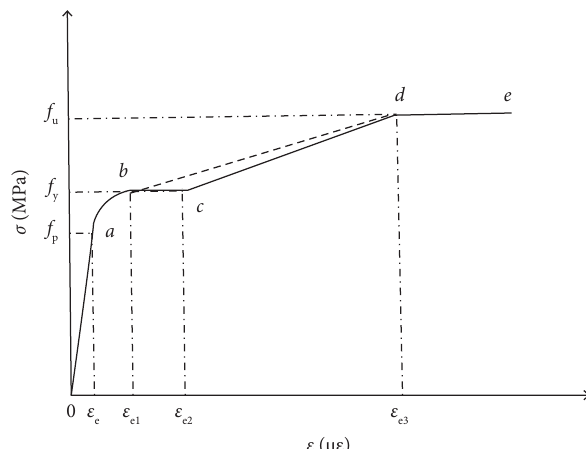
Figure 16: Adjustment of steel constitutive relationship.